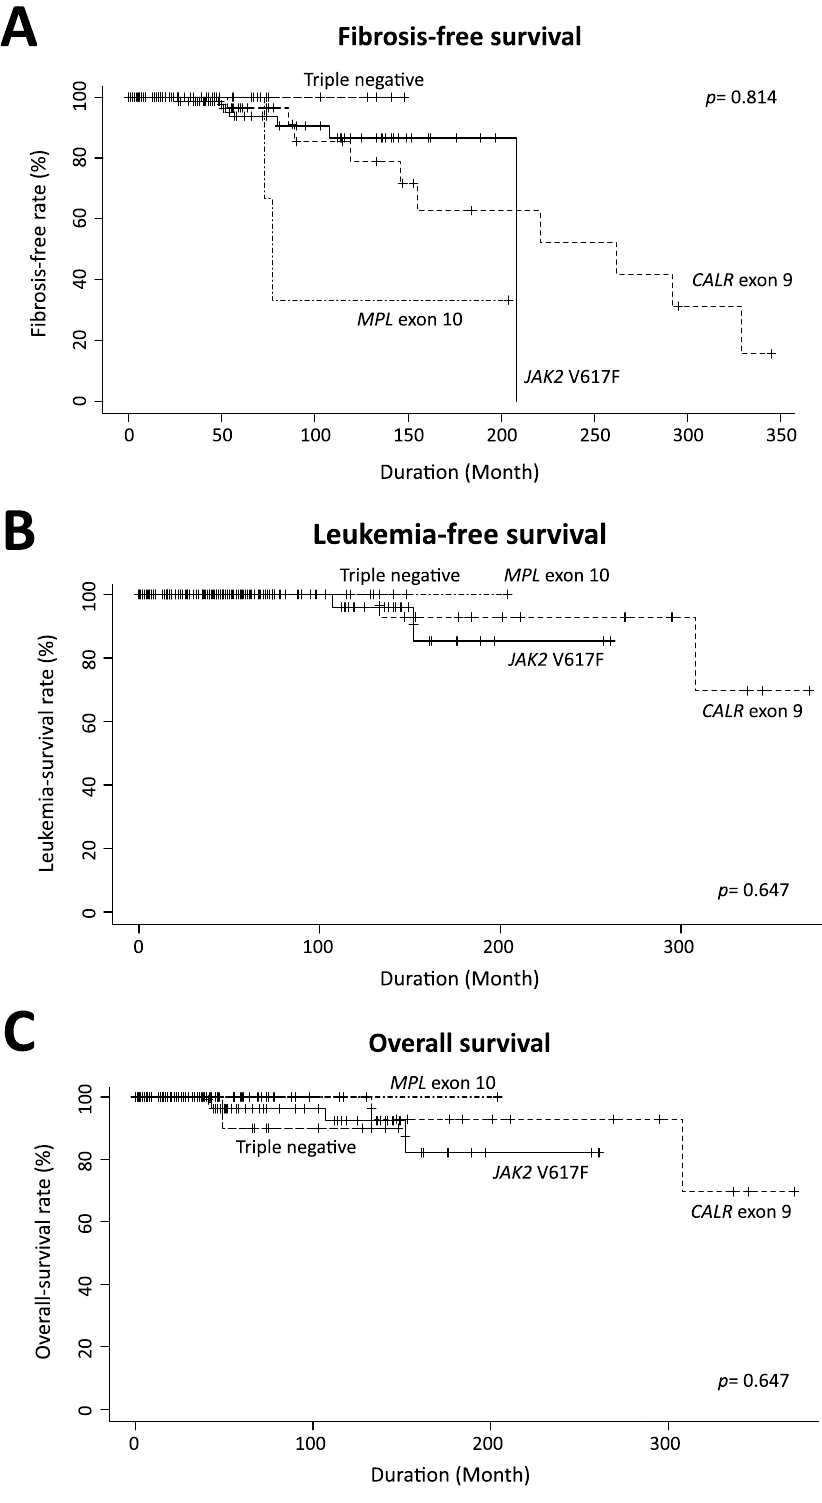
Figure 2. Survival data of the ET patients grouped by driver mutation status. The fibrosis-free survival ( A ), leukemia-free survival ( B ), and overall survival ( C ) of the patients stratified by driver mutation status are